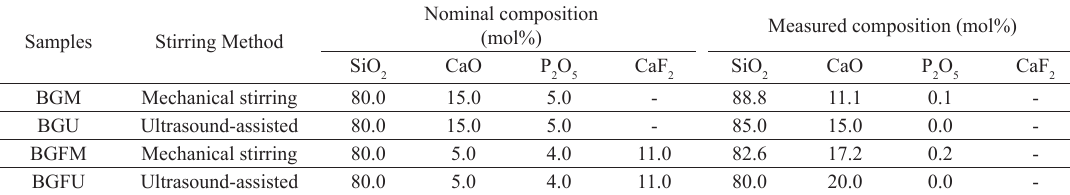
Table 1. Nominal composition and compositional analysis (mol%) of the bioactive glasses stabilized, determined by lithium metaborate fusion and ICP.